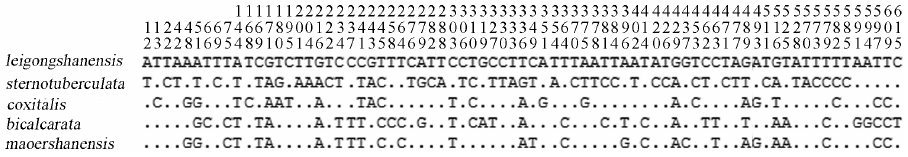
Figure 38. Variable sites from mitochondrial COI gene sequence alignment. Numbers arrayed vertically represent the positions of the nucleotides.